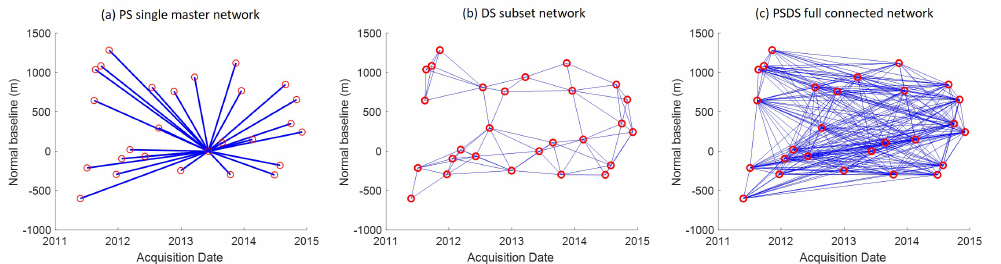
Figure 1. An example of interferogram networks. ( a ) The single master network in Persistent Scatterer Interferometry (PSI), see Section 3. ( b ) The subset network consisting of interferograms with short spatial and temporal baselines in the Small Baseline Subset (SBAS), see Section 4. ( c ) The fully connected network in the Permanent Scatterer Distributed Scatter (PSDS)